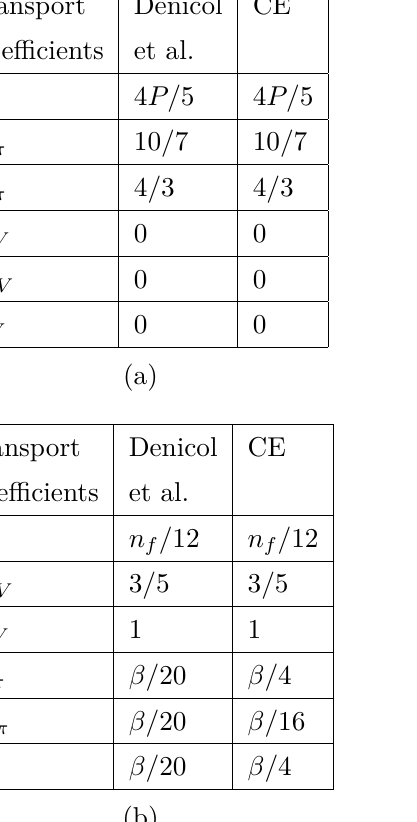
Table 1 . (a) Comparison between the coefficients for the shear-stress equation for a massless Boltzmann gas (here we compare the result for particles only) calculated in this work using CE method and Denicol et al. using the 14-moment method in ref. [65]. (b) Comparison between the coefficients for the diffusion equation for a massless Boltzmann gas calculated in this work using Chapman-Enskog method (CE) and Denicol et al. using the 14-moment method in ref. [65] (particles only). (c) Transport coefficients appearing in the shear, bulk and diffusion equation that couple magnetic field and dissipative quantities for a massless Boltzmann gas (particles